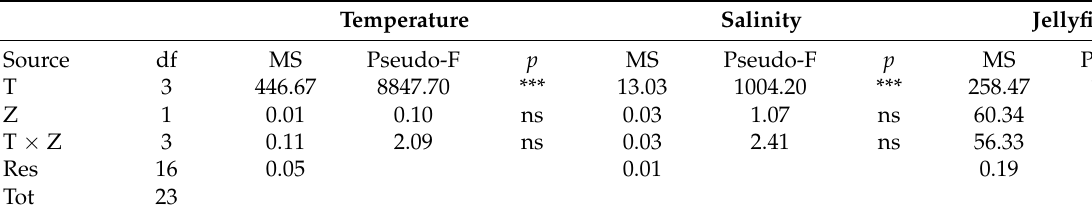
Table 1. Results of the permutational analyses (PERMANOVA) on water salinity, temperature, and jellyfish density in the W and E zones (Z) among sampling times (T). Abbreviations: Res—residual; Tot—total; df—degrees of freedom; MS—mean squares; Pseudo-F—F critic; P—permutational level